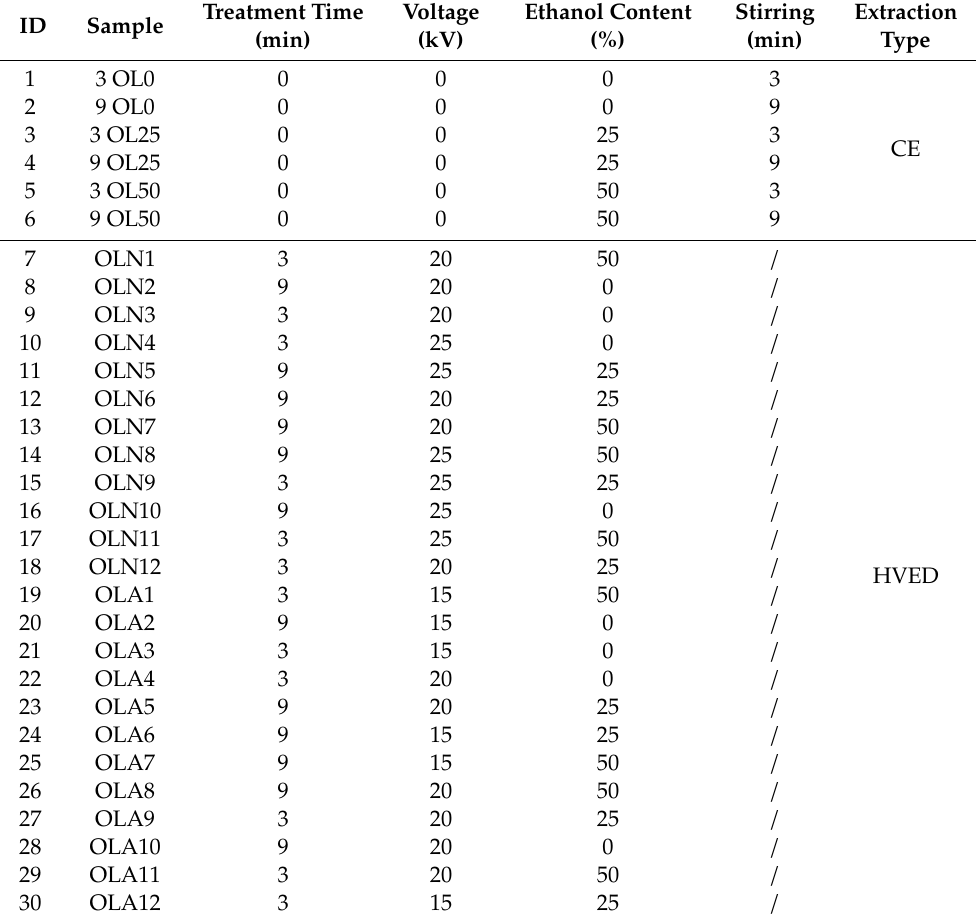
Table 1. Denotation of sample for high voltage electrical discharges (HVED)